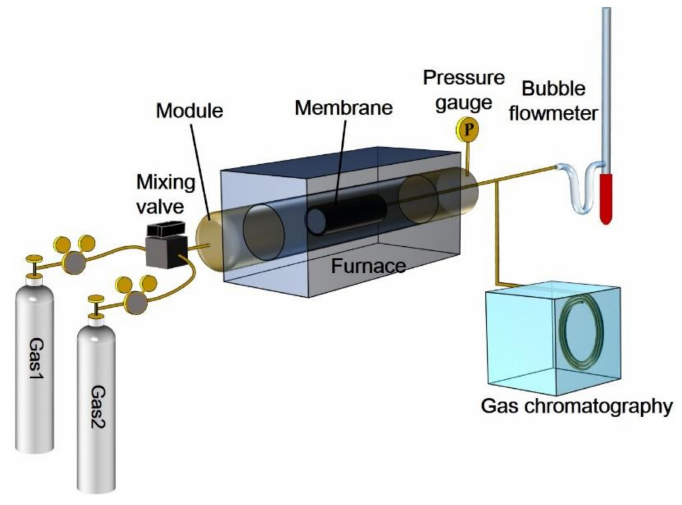
Figure 5. Diagram of the permeation/separation experimental set